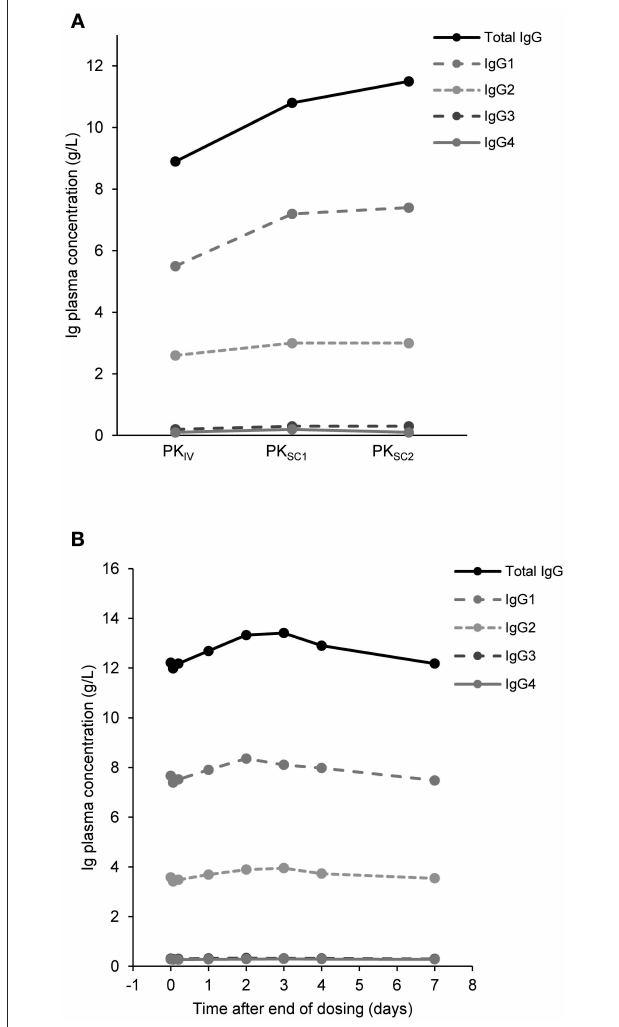
FIGURE 3 | IgG concentrations over time. (A) Median trough concentrations of IgG and its subclasses after IVIG infusion (PK IV ) and after octanorm infusions at 11 (PK SC1 ) and 28 weeks (PK SC2 ). For PK IV and PK SC1 N = 22, for PK SC2 N = 21. N, number of patients; IgG, immunoglobulin G; PK IV , PK following IVIG prior to the switch to octanorm; PK SC1 , PK after the 11th infusion of octanorm; PK SC2 , PK after the 28th infusion of octanorm—at steady state. (B) IgG levels over 7 days after infusion. Data are shown for the 22 patients who participated in the PK sub-study and had IgG measurements at week 28 (PK SC2